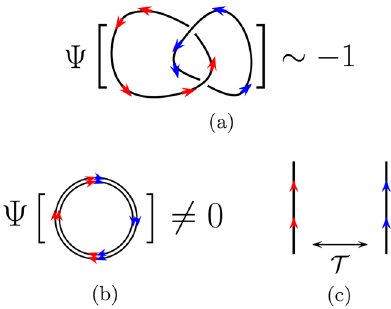
M U ð 1 Þ spin bT f